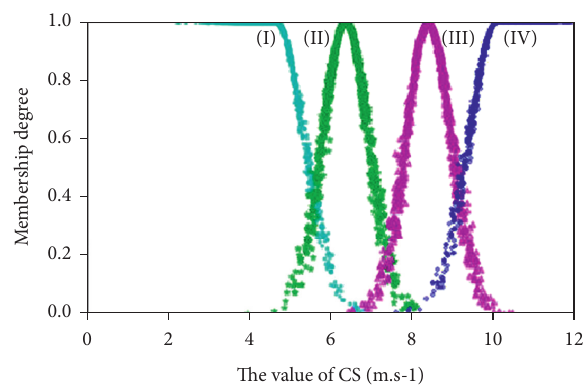
Figure 7: Cloud model for the CS.